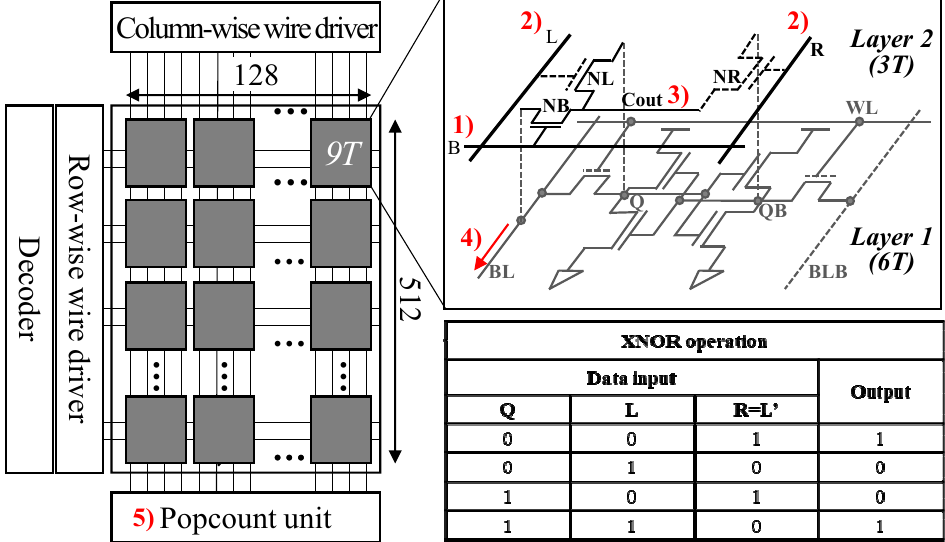
Figure 1. Design and operation procedure of a CiM_SRAM subarray. Note the design of CiM_SRAM subarray is reproduced from [9] and we demonstrate the truth table of XNOR operation in the CiM_SRAM design.